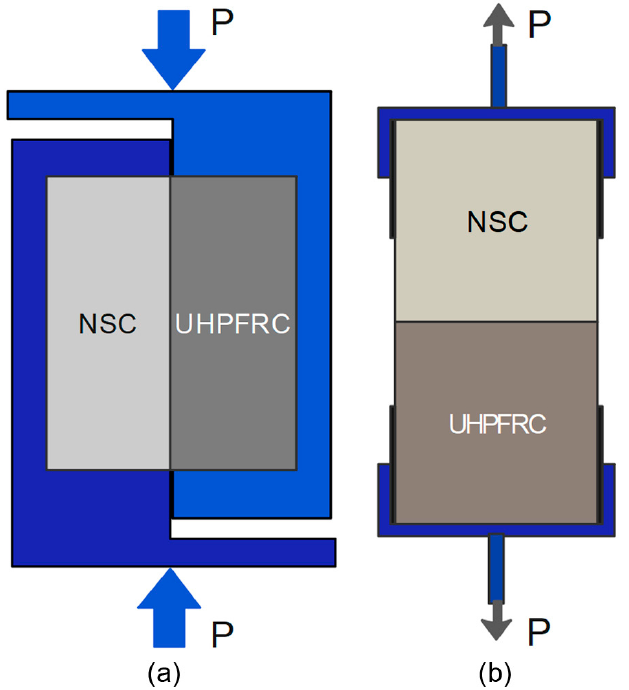
Figure 1. Types of tests: ( a ) simple shear bonding test; and ( b ) pure tensile bonding test. The tensile strength is calculated based on the pull-off test (Figure 1b) according to ASTM C1583/C1583M [16] and is shown as follows: